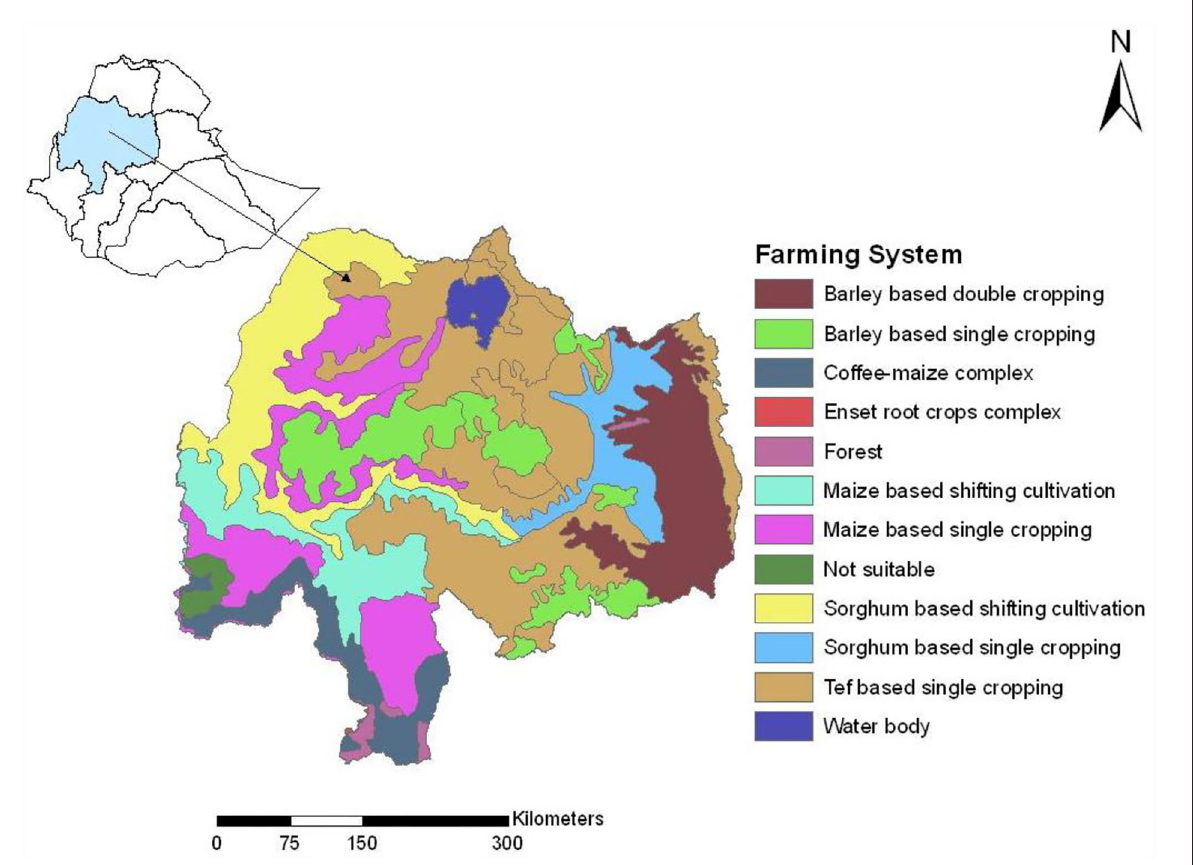
FIGURE5 The major farming systems of the basin. Source (Erkossa et al.,